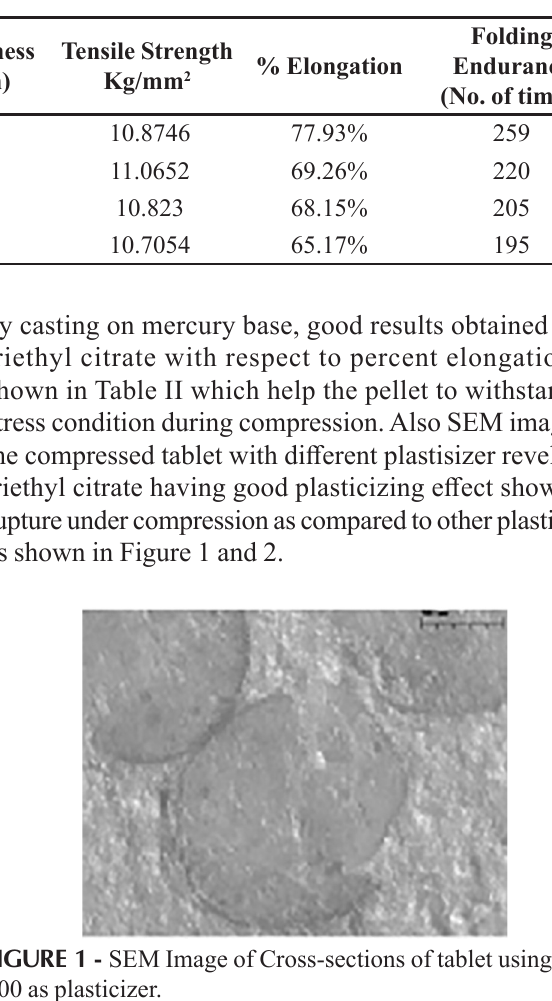
TABLE II - Evaluation of patches prepared by using single polymer containing optimized concentration of different plasticizer